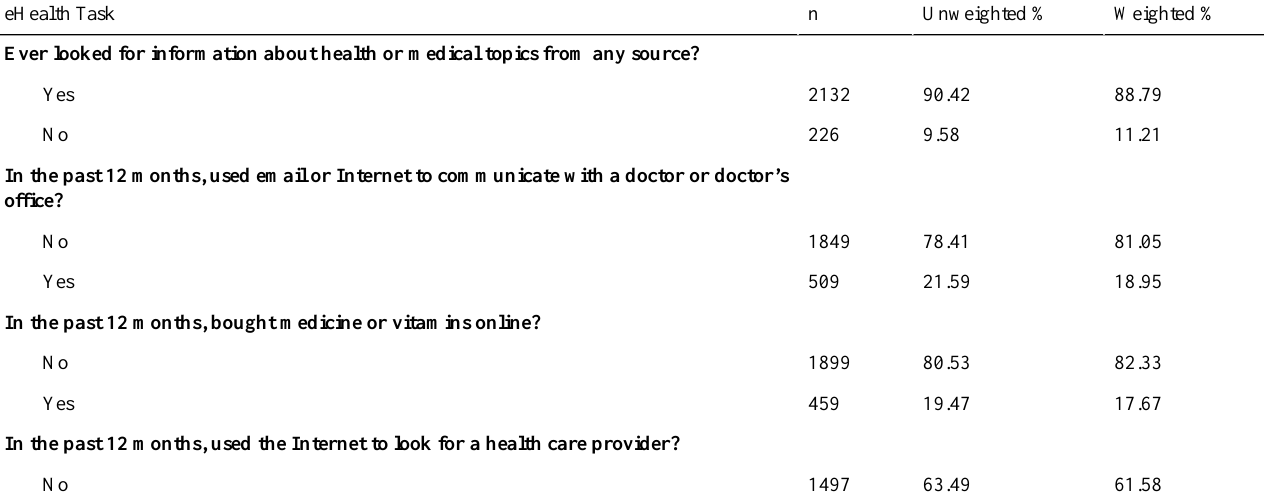
Weighted %Unweighted %neHealth Task